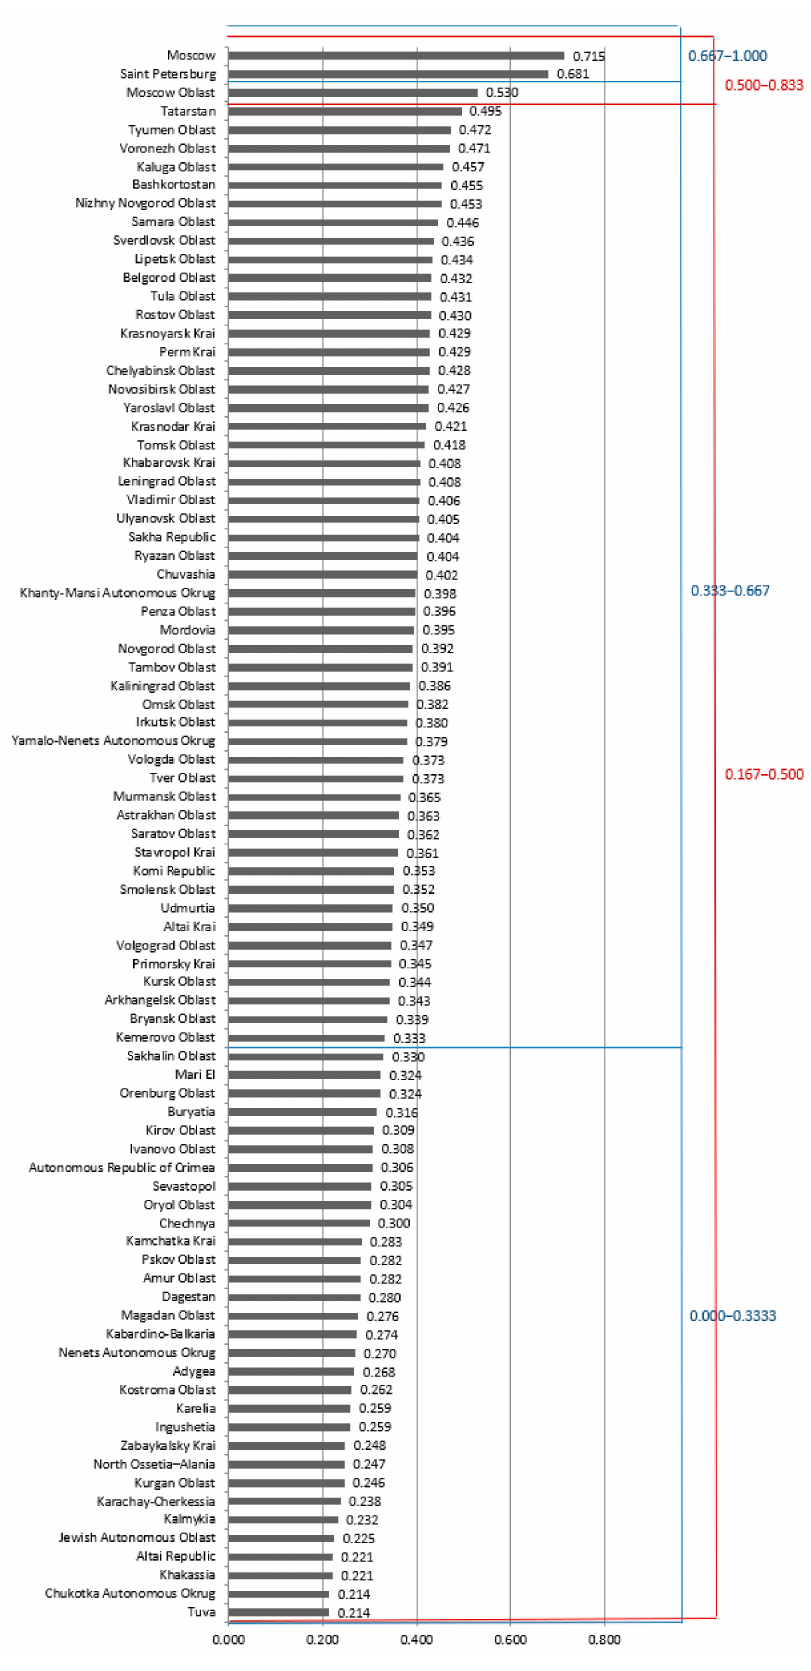
Figure 3. Rating of regions according to aggregate indicator Y “the level of preparedness of the region for digitalization of the construction complex”,